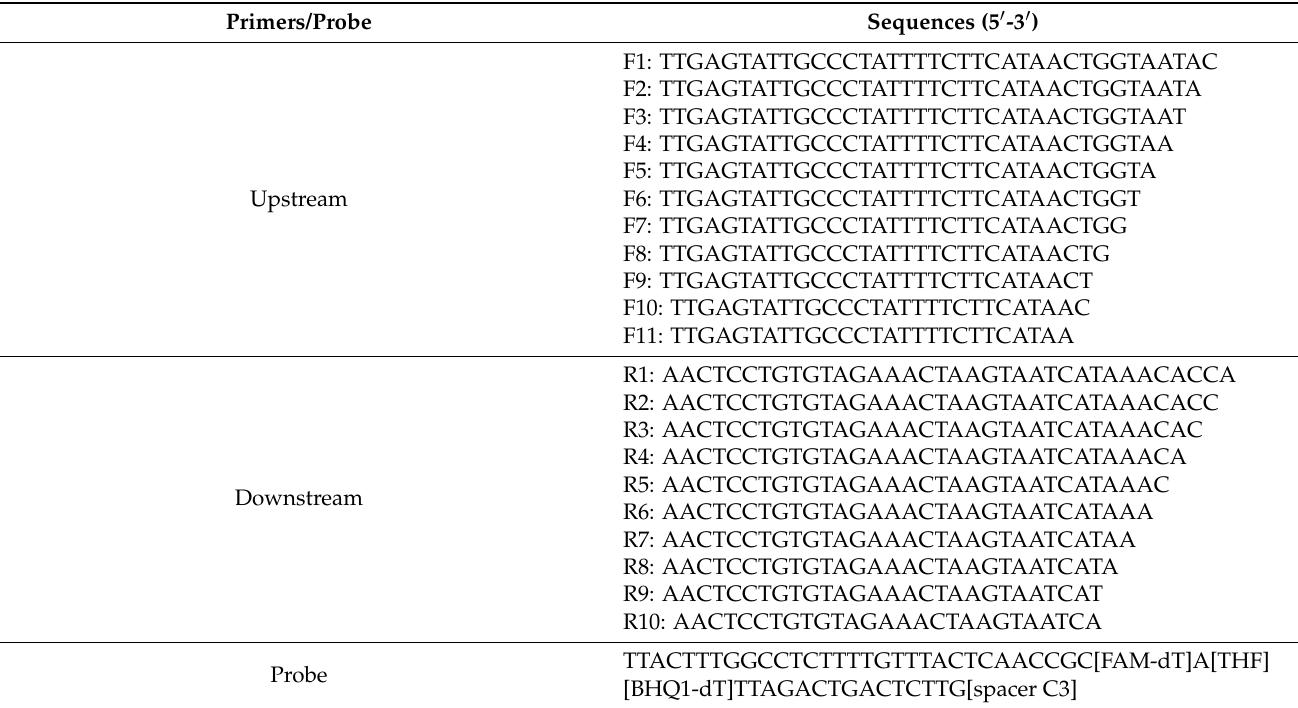
Table 1. The sequences of primers and probe used in this